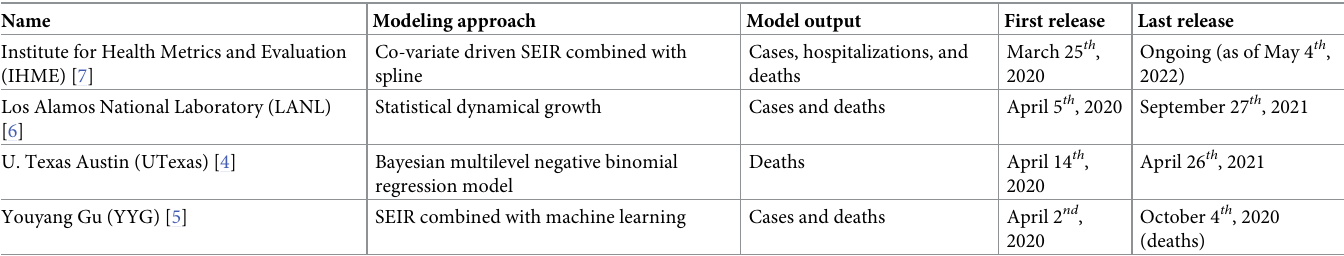
Table 1. List of models